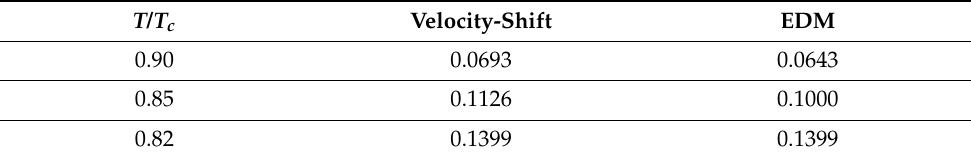
Table 2. Comparison of the maximum spurious currents for different forcing